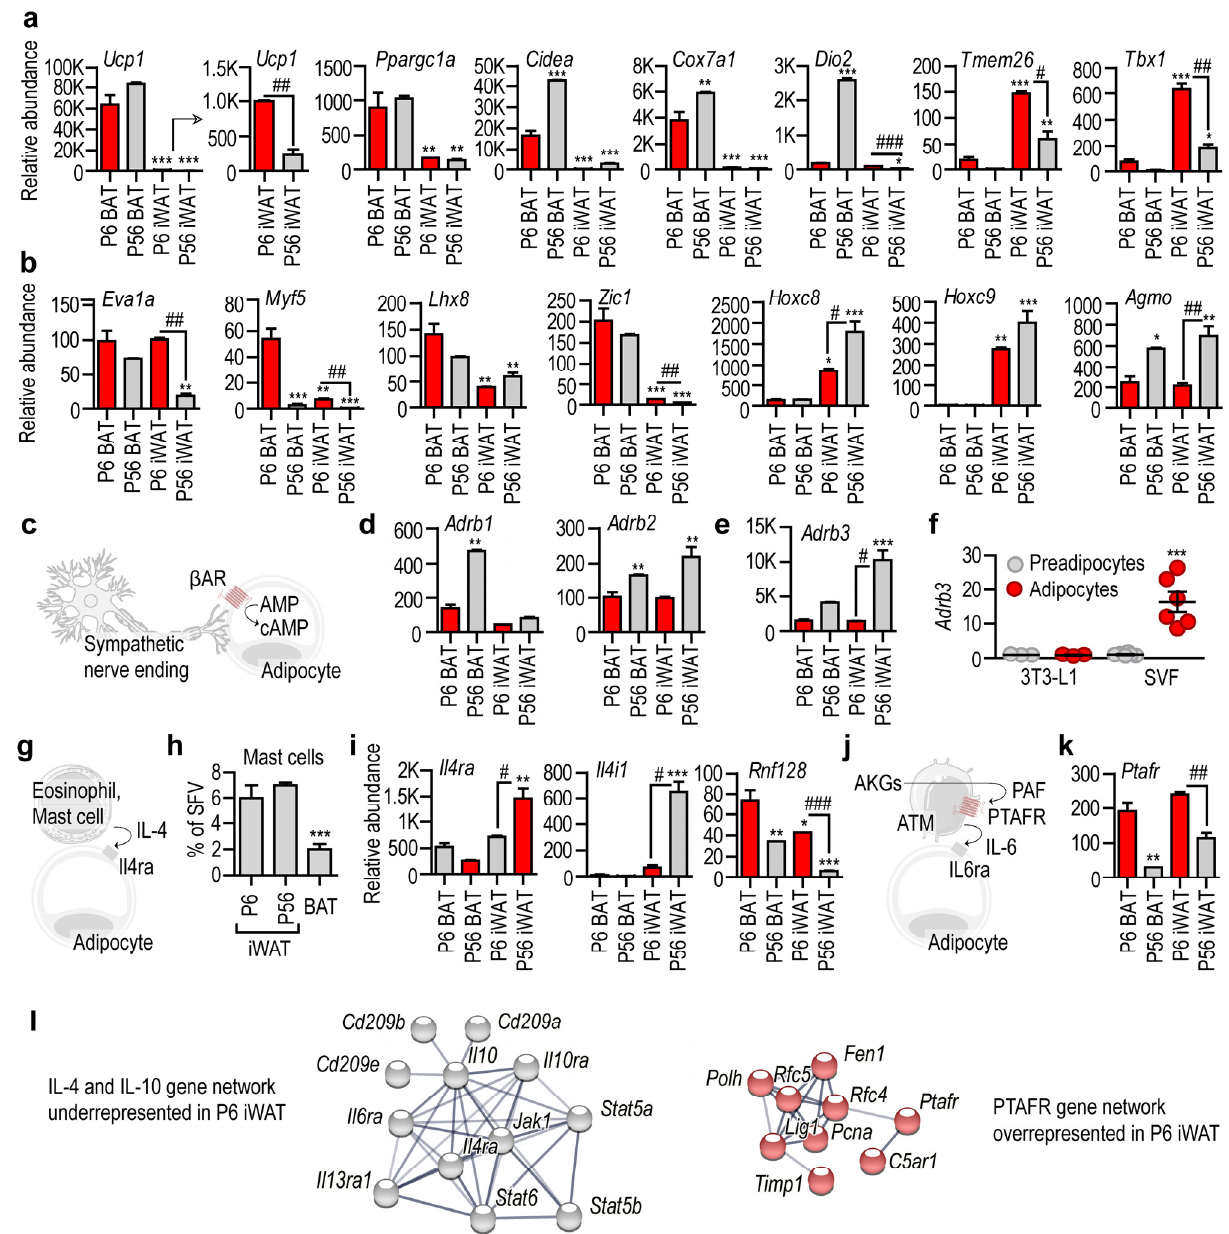
Figure 5. Transcription of beige-marker genes and beige-inducing signal pathways. ( a , b ) Transcript level of genes previously defined as markers of BAT and beige adipocytes. Ucp1 is key for nonshivering thermogenesis; Ppargc1a is a regulator of mitobiogenesis; Cidea , Cox7a1 , Dio2 , Tmem26 and Tbx1 are markers of beige adipocytes; Eva1a is a marker of BAT; Myf5 is expressed by progenitors of BAT adipocytes; Lhx8 and Zic1 are markers of BAT. The levels of Hoxc8 and Hoxc9 increase during WAT adipocyte development. Agmo is responsible for the degradation of beige adipocyte-inducing lipid species, so-called alkylglycerols (AKGs). ( c ) Scheme of beige induction by β -adrenergic stimuli of the sympathetic nervous system. ( d ) Level of β -adrenergic receptors. ( e ) Level of Adrb3 in the various fat depots. ( f ) Adrb3 level in 3T3-L1 preadipocytes and in in vitro cultured primary preadipocytes of the iWAT stromal vascular fraction (SVF). Adipocyte development was chemically induced. ( g ) Scheme of IL-4-induced adipose tissue browning. ( h ) Percentage of mast cells in the SVF of iWAT and BAT. ( i ) Expression level of IL-4 signaling in the various fat depots. ( j ) Scheme of adipose tissue browning induced in postnatal life by the AKG–PAF–IL-6 axis. ( k ) Expression of Paftr . ( l ) Underrepresented gene network of IL-4 signaling in P6 iWAT. Overrepresented gene network of PAF signaling in P6 iWAT. PPI enrichment p -value < 1.0 × 10 − 16 . * p < 0.05, ** p < 0.01, *** p < 0.001, two-way ANOVA with Dunnett´s post hoc test, using P6 BAT as reference group, # p < 0.05, ## p < 0.01, ### p < 0.001, Student´s unpaired, two-tailed t -test.